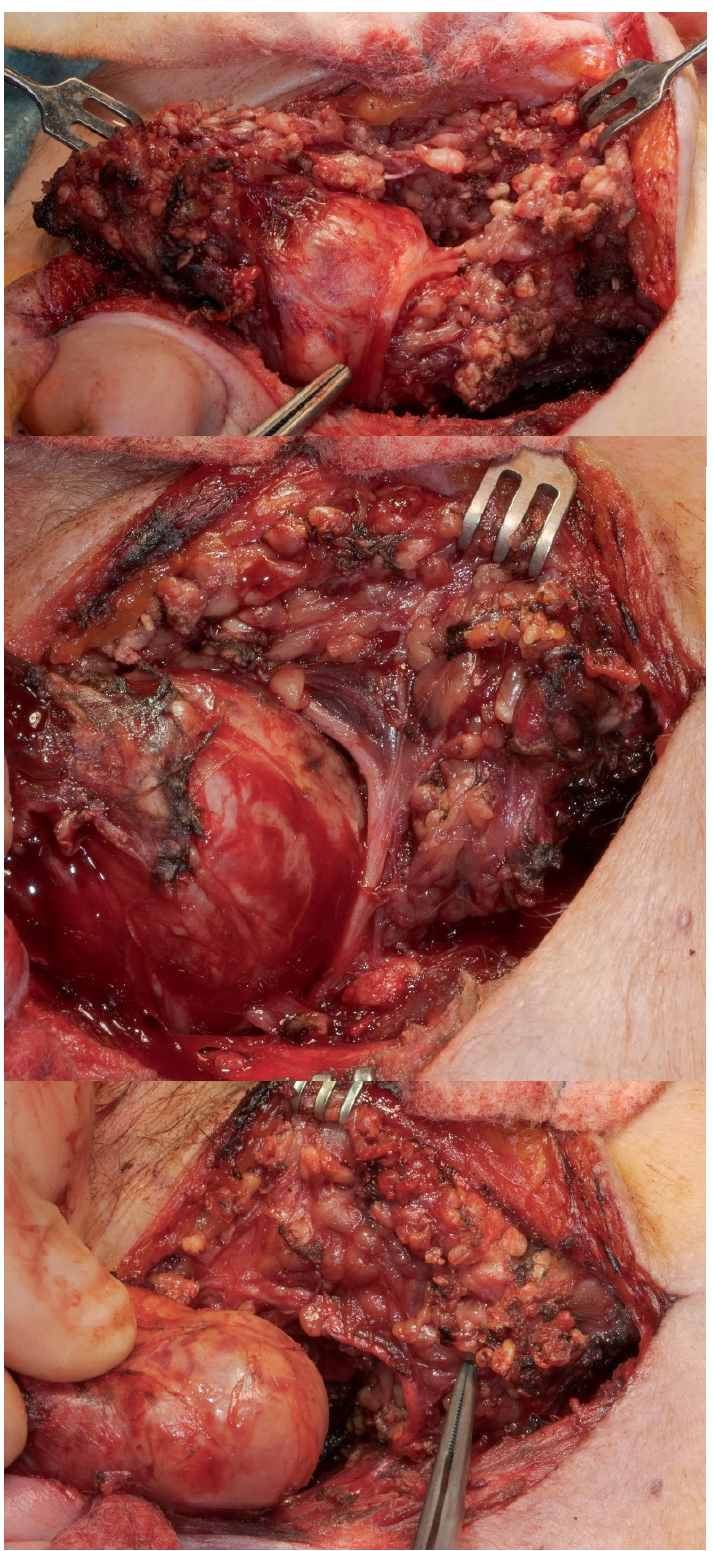
Figure 3. Benign tumor of the right parotid gland (histology: pleomorphic adenoma), with massive adhesions and major displacement of the main trunk and bifurcation of the facial nerve.